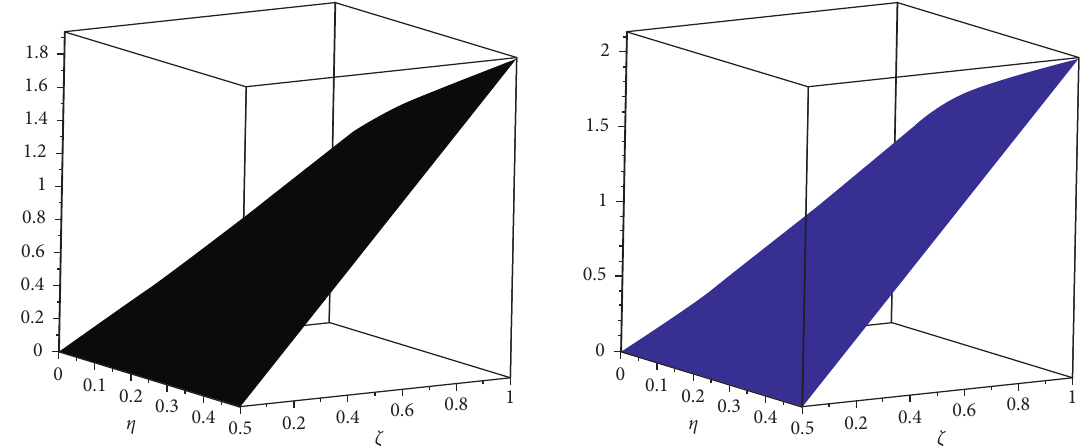
Figure 2: The approximate result graph of problem 4.1, at δ � 0 . 6 and 0.4.